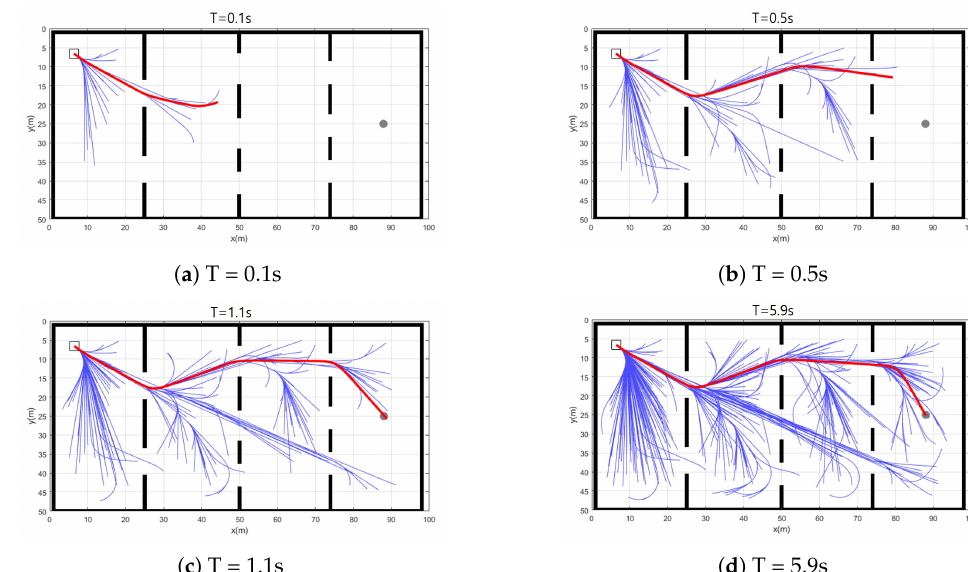
Figure 5. Resultant trajectories of CDT-RRT* from simulation 2.